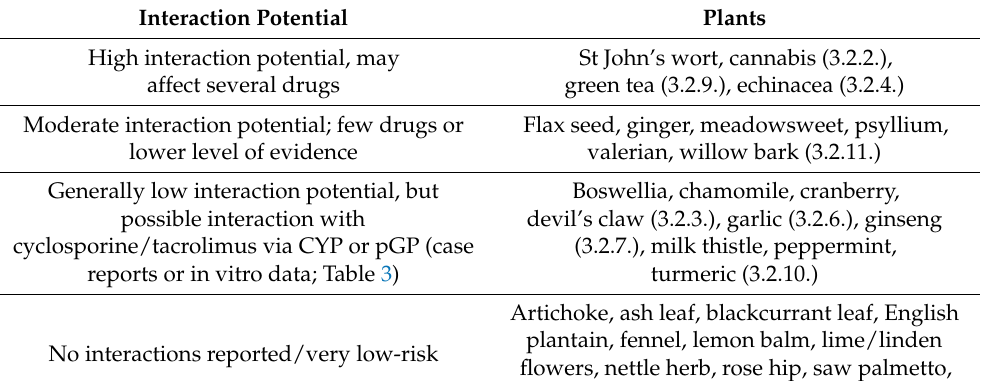
Table 4. Short summary of the interaction risk of the reviewed plants in RA, IBD, and osteoarthritis treatment. Details can be found in Table 3 and Section